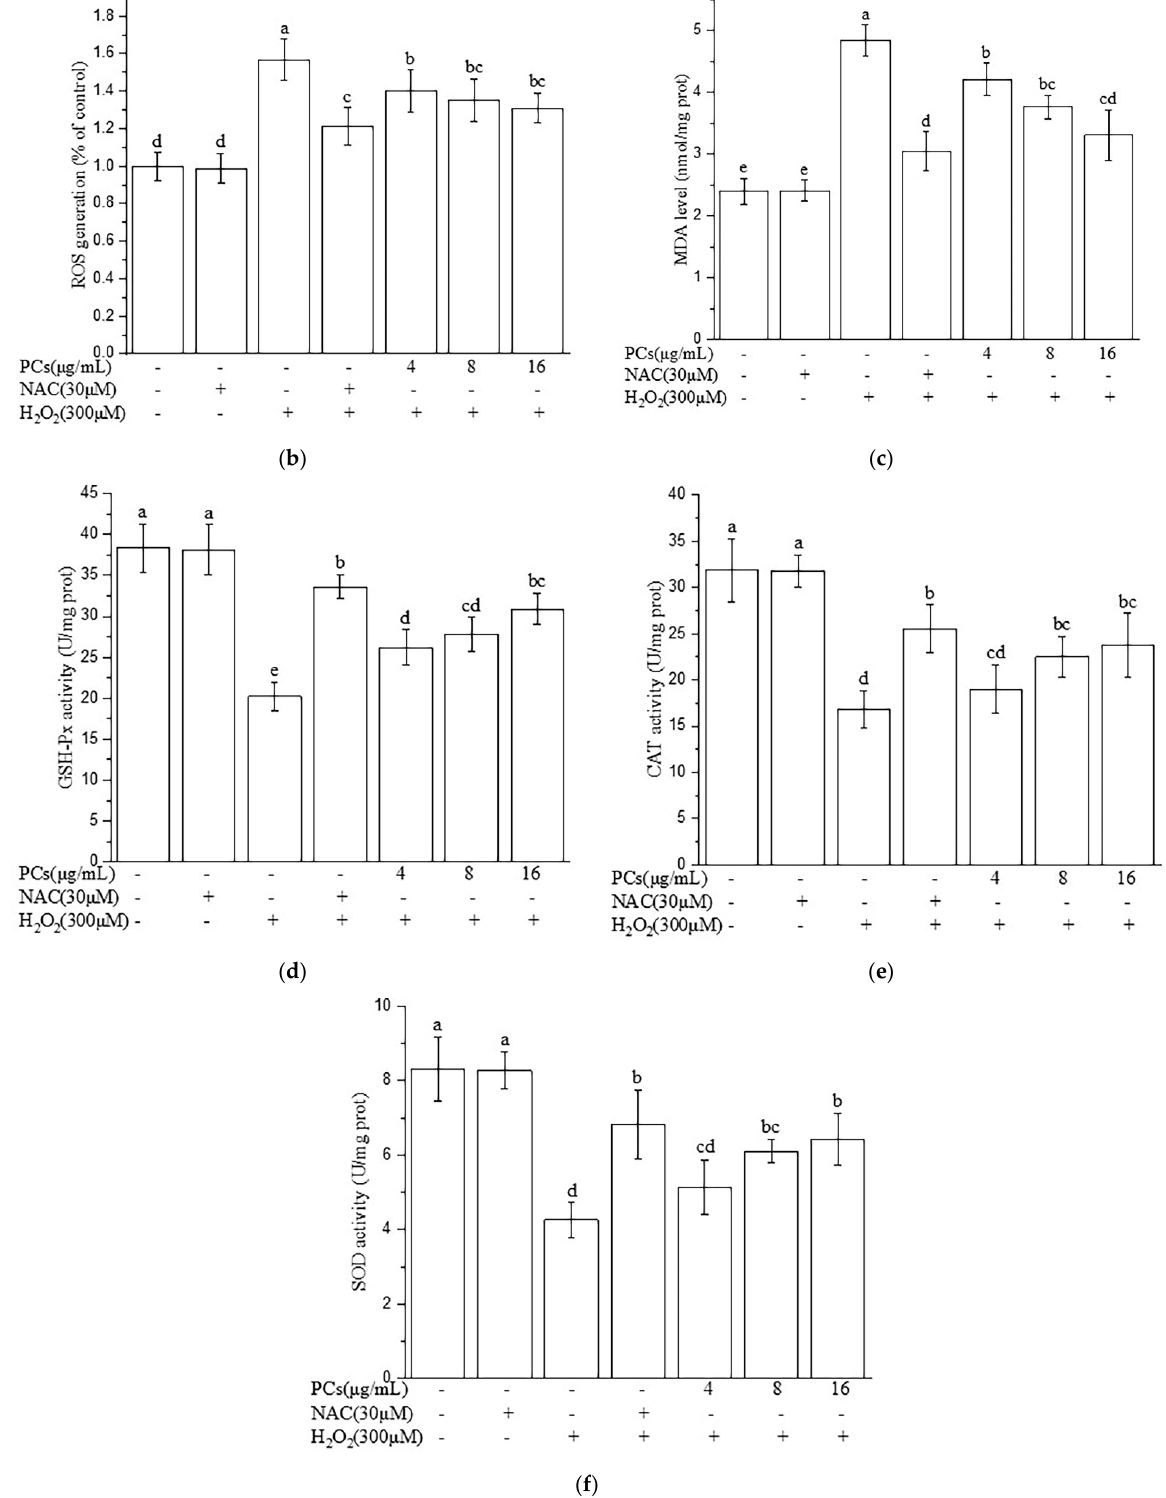
Figure 6. Effects of PCs on oxidative stress in H 2 O 2 -treated zebrafish larvae. ( a ) Representative fluorescence photomi- crographs of zebrafish larvae; ( b ) ROS levels were measured via imaging software; ( c ) MDA levels; ( d ) GSH-Px activity; ( e ) CAT activity; ( f ) SOD activity. Data are expressed as the mean ± SD. All experiments were conducted three times. Values with different letters above are significantly different ( p < 0.05, one-way